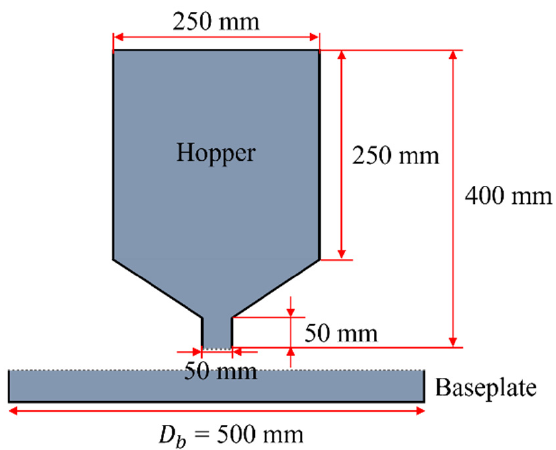
Figure 3. Illustration of experimental set up for angle of repose [47].